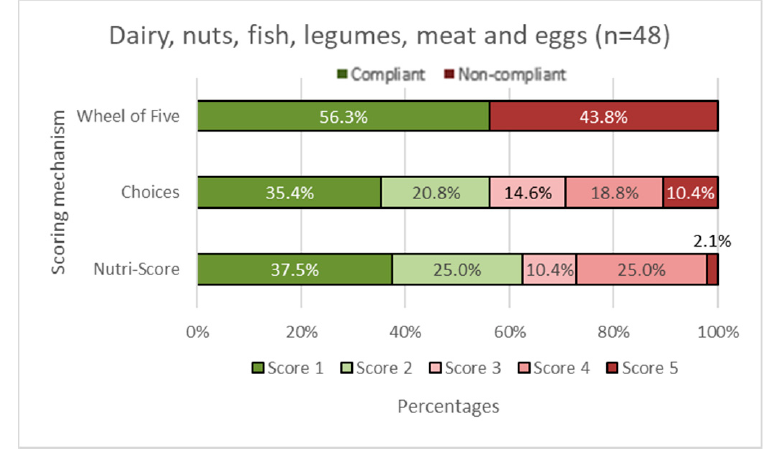
Figure 4. Dairy, nuts, fish, legumes, meat, and eggs group. The first horizontal bar shows the percentages of products that are compliant/non-compliant with the Wheel of Five. The Choices score and Nutri-Score show the percentages of products that scored 1 to 5. Nutri-Score 1 equals a score of A, Nutri-Score 2 equals a score of B, etc. Scores 1 and 2 (green shades) are considered healthy (compliant with the Wheel of Five) and scores 3, 4, and 5 (red shades) are considered less healthy (non-compliant with the Wheel of Five).